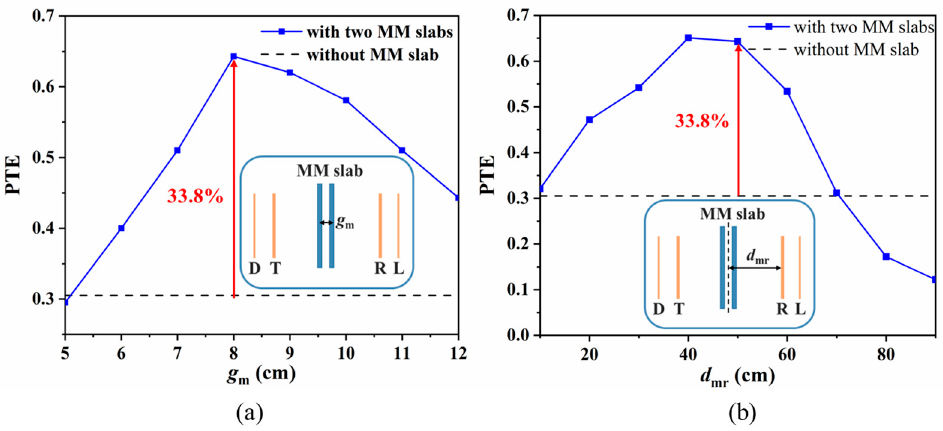
Figure 9. The PTE of a system with two MM slabs as a function of ( a ) g m and ( b ) d tm.